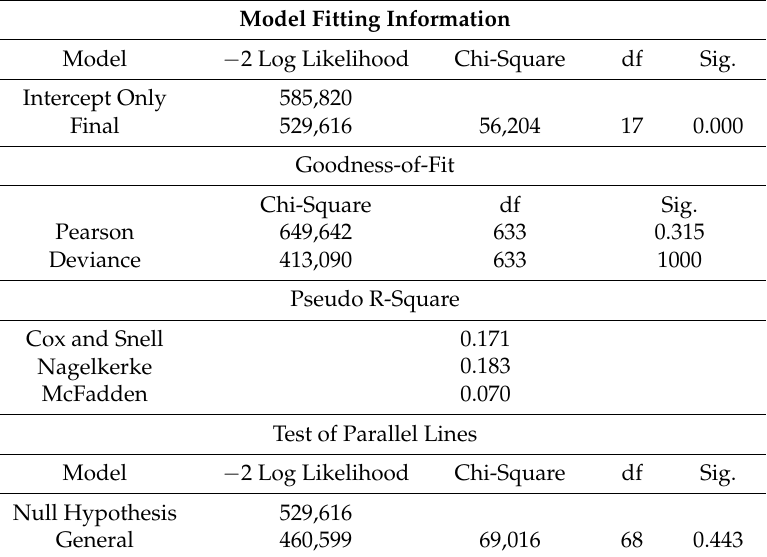
Table 7. Overall fitting indices for the walking model.